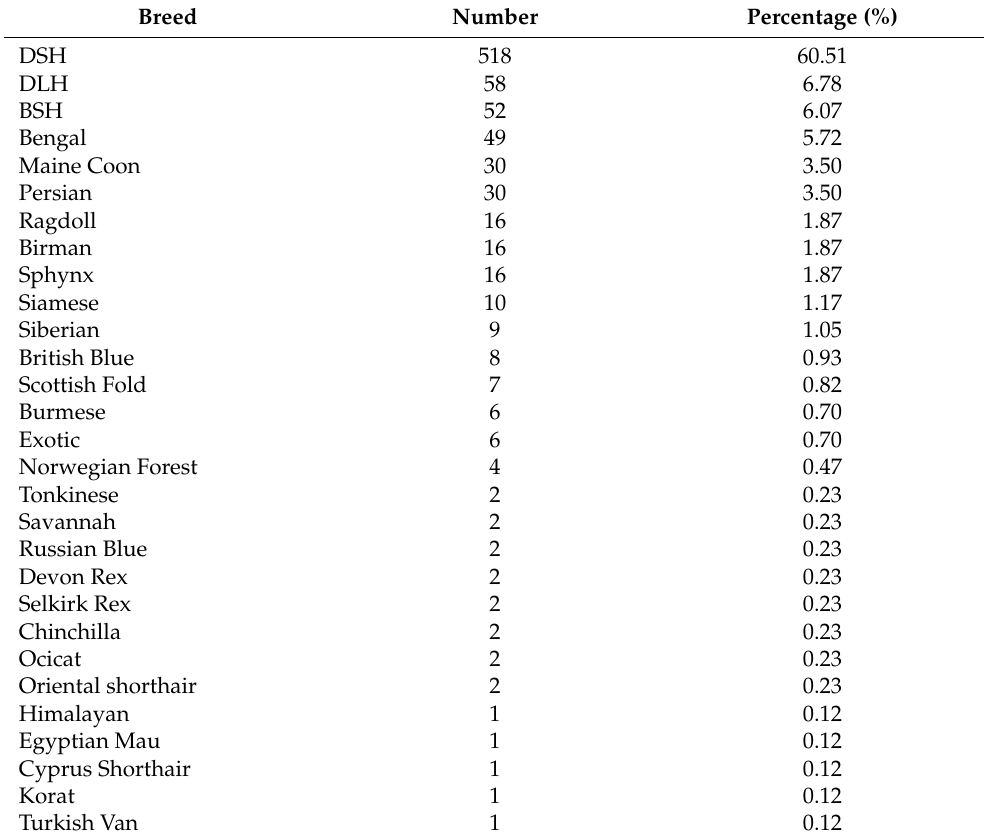
Table 1. List of breeds included in the study and their prevalence in the selected population of 856 cats with heart